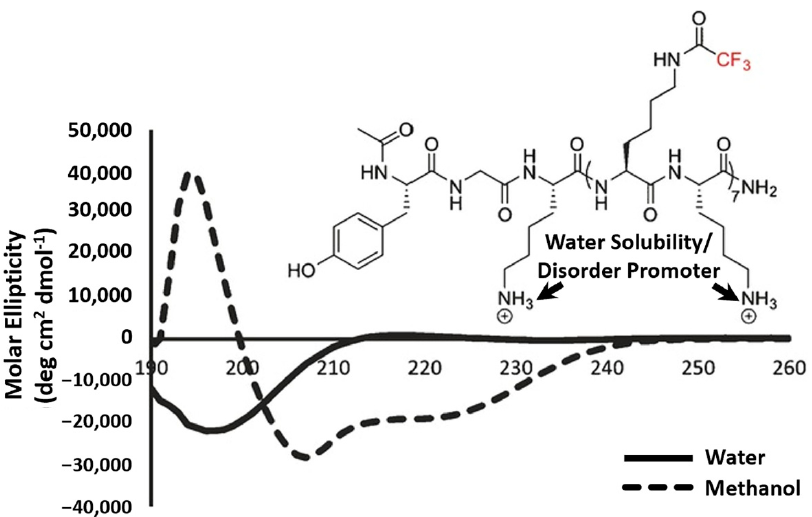
Figure 7. Structure of the intrinsically disordered peptide containing lysine and TFA-lysine accompanied by far-UV circular dichroism spectra in water and in methanol. Adapted with permission from [36]. Copyright 2017 Wiley-VCH Verlag GmbH & Co. KGaA, Weinheim.